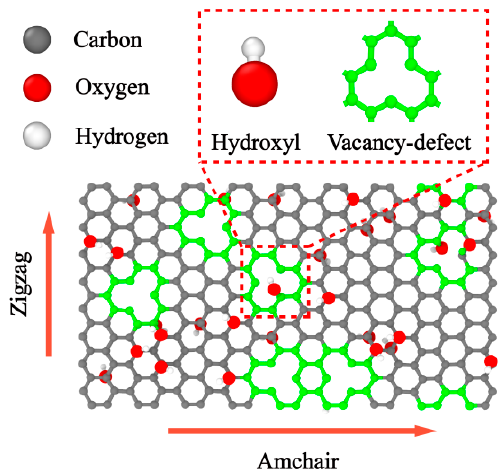
Figure 1. Schematic picture of graphene oxide (GO) with randomly distributed vacancy defects and hydroxyl groups.